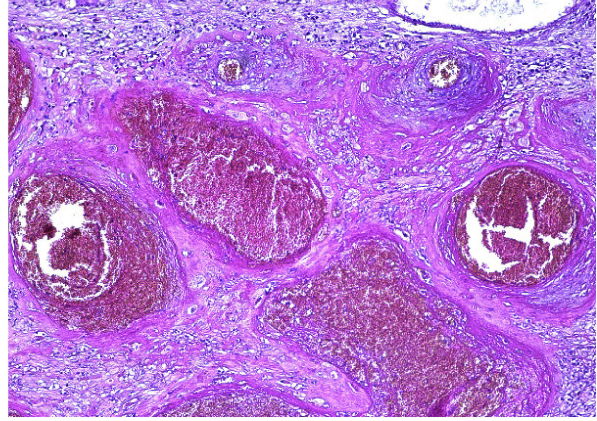
Figure 8. Dilated irregularly shaped blood vessels and thrombosis (HE × 10).